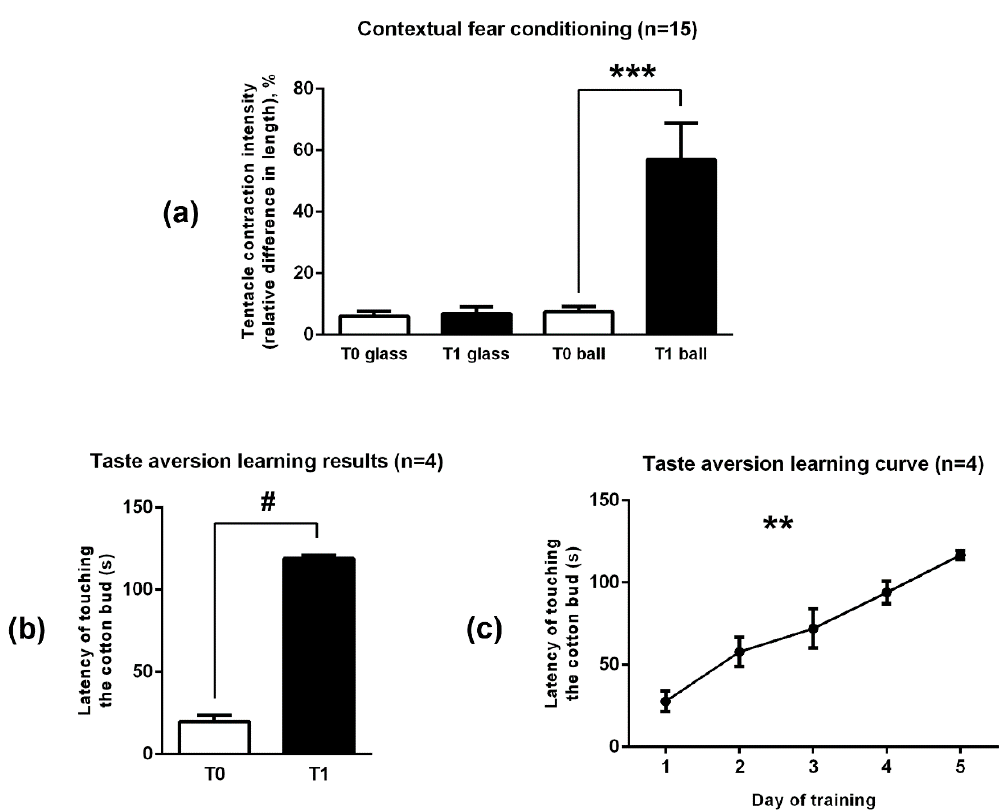
Figure 4. Snail training results: ( a ) Tentacle contraction intensity (relative length decrease) caused by the same mechanical stimuli applied to snails in control (glass) and experimental (ball) context before (T0) and after (T1) contextual fear conditioning. ( b ) Latency of the consummatory reaction to the presented carrot smell before (T0) and after (T1) taste aversion learning. ( c ) Latency of the consummatory reaction for every day of training during taste aversion learning. Data are present as AM ± SD. ** p < 0.005, Friedman ANOVA, *** p < 0.001, Wilcoxon matched pairs test, # p = 0.068, Wilcoxon matched pairs